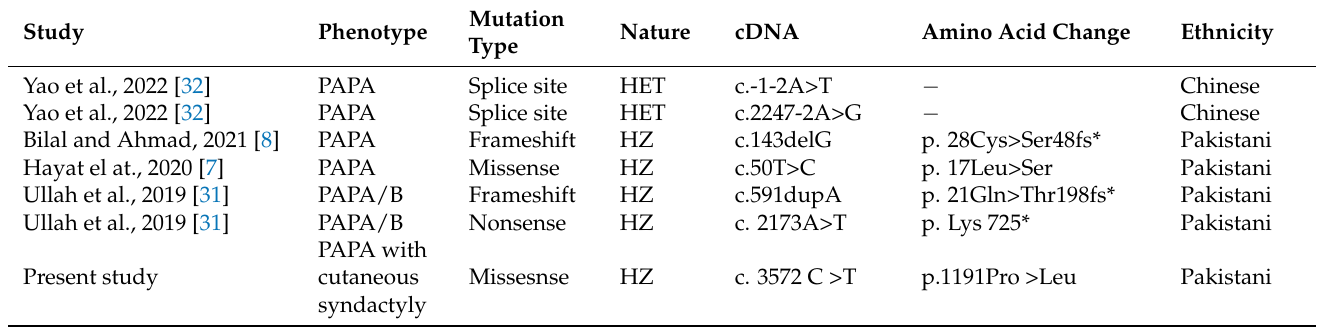
Table 3. Description of previously reported mutations in KIAA0825 in association with PAP.